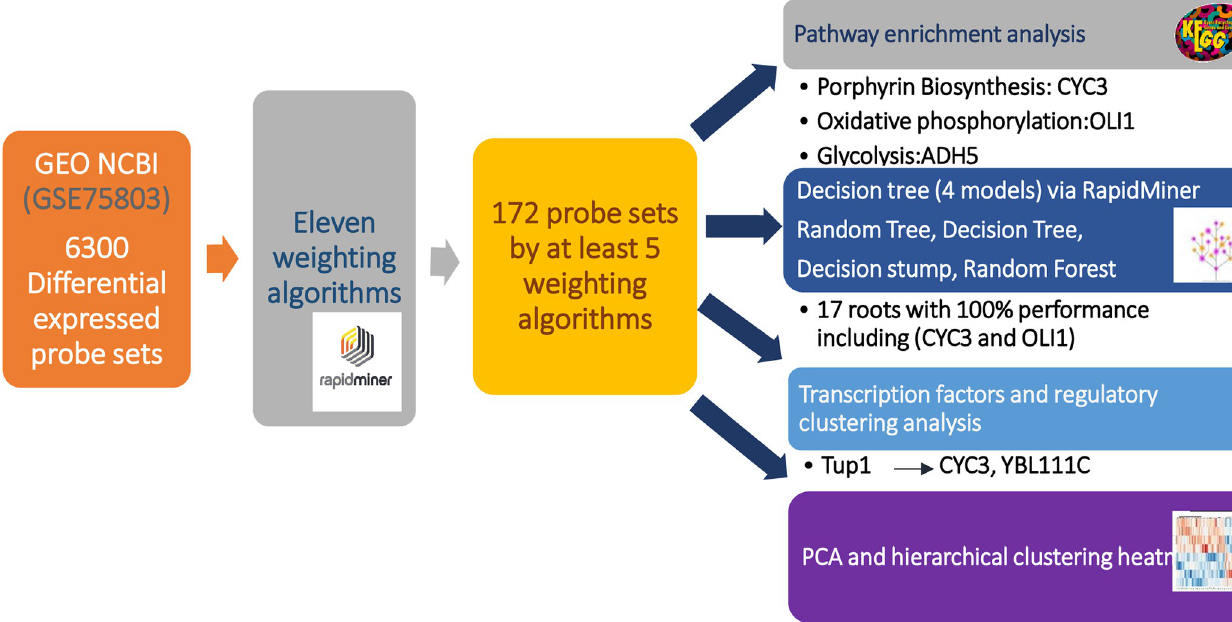
Fig 4. The schematic illustrates the methodology of the study with summarized results.